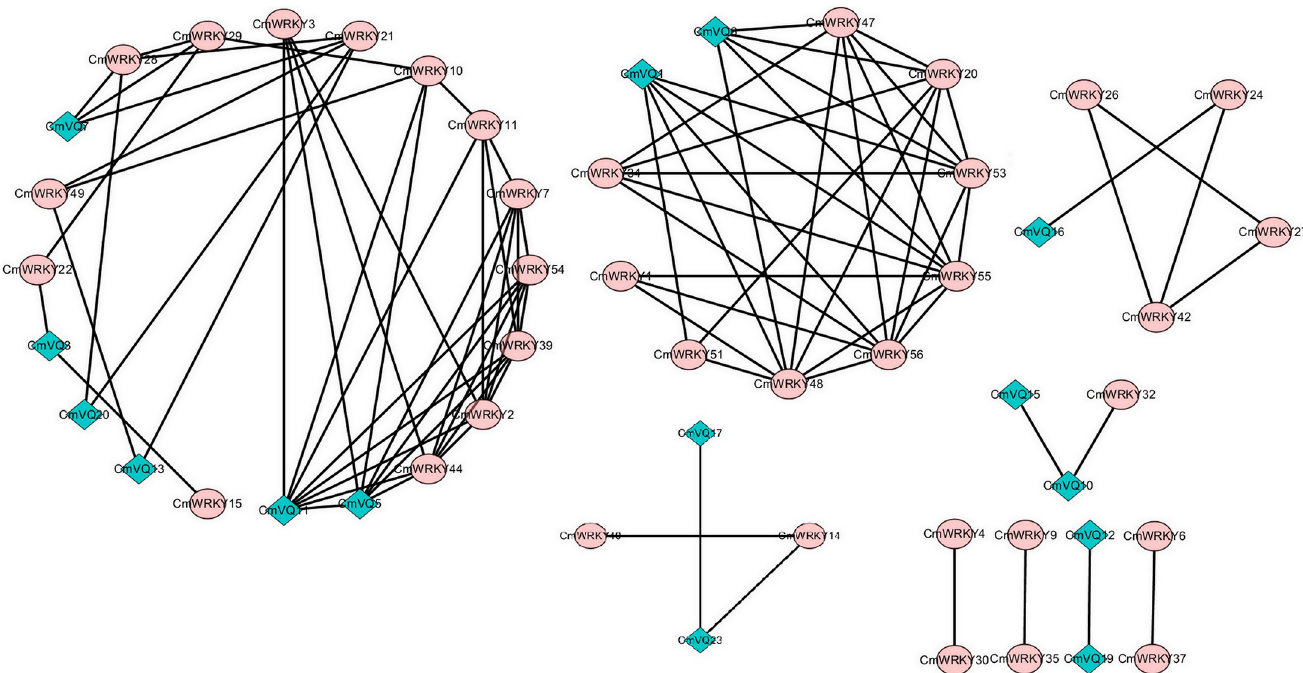
Fig 6. Co—expression network of melon WRKY genes and VQ genes according to correlation coefficient > 0.7 and p < 0.05. The circles represent CmWRKY genes and the diamonds represent CmVQ genes.